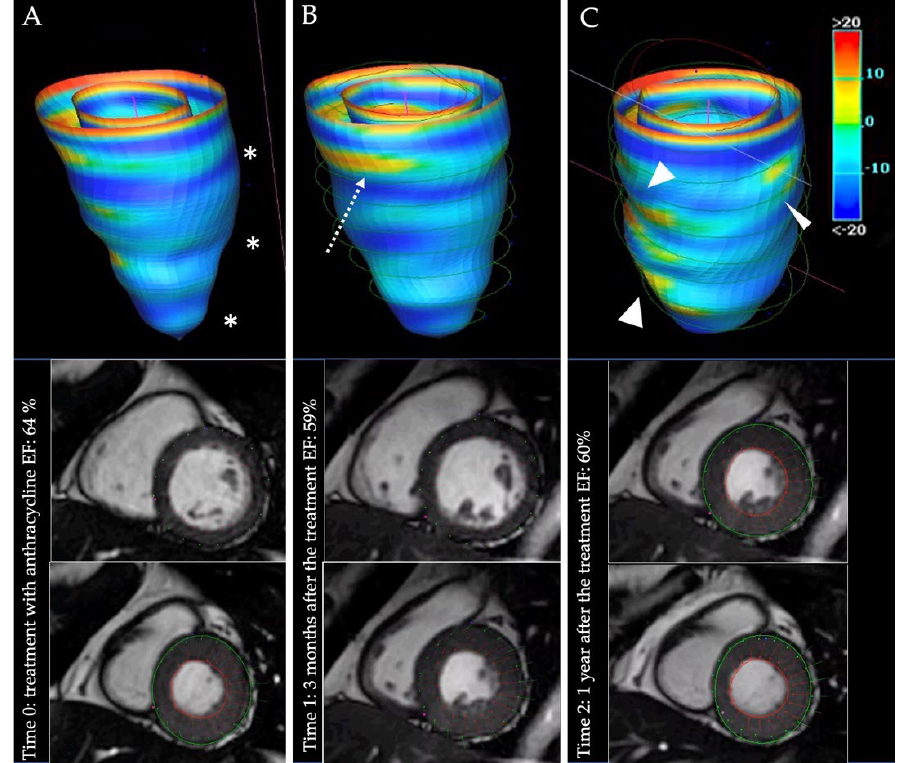
Figure 5. Panels ( A – C ) show the evolution of a cardiotoxic CHT with anthracycline. In panel ( A ), CMR examination obtained before the CHT. In panel ( B , C ), SA cine images of CMR examinations acquired at 3 and 12 months after the treatment. On the right, a volume rendered reconstruction obtained after contouring of entire SA stack, with a colorimetric map of peak strain. Colors correspond to the degree of deformation: brighter colors represent lower level of deformation. Similar kinesis and overall ventricular function are clearly preserved during the three examinations. In panel ( A ), overall longitudinal deformation is preserved (blue colors; white asterisks). In panel ( B ), the dotted white arrow highlights a lower deformation of basal segments compared to the first examination. Finally, after 12 months (panel ( C )), peak strain analysis highlighted different areas of lower deformation (white arrowheads) and overall brighter colors meaning a reduced strain. CHT: chemotherapy; CMR: cardiac magnetic resonance; SA: short axis.